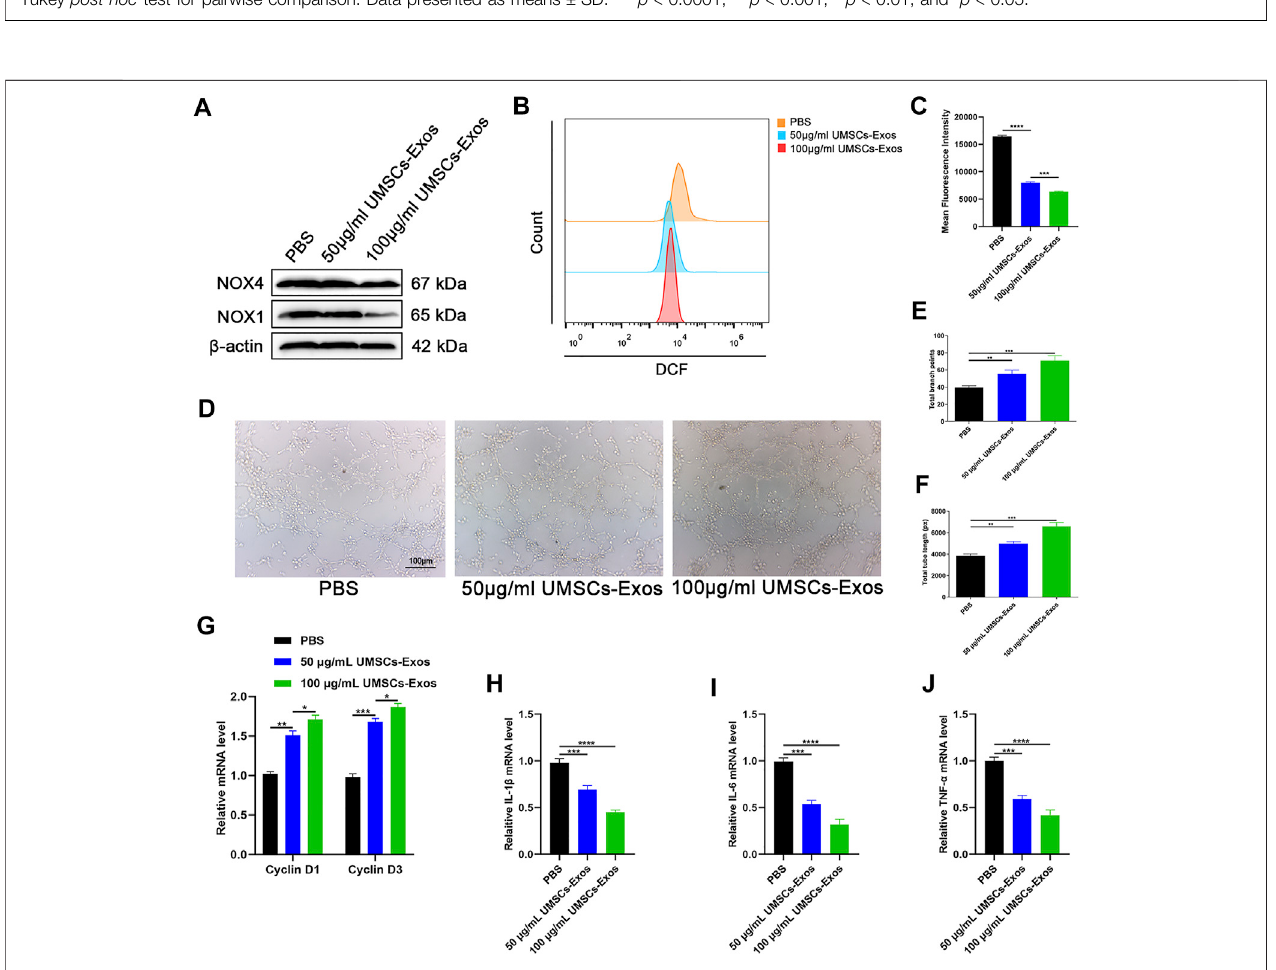
FIGURE 4 | HUC-Exos can improve oxidative stress injury caused by hyperglycemia in vitro . (A) Western blotting results of NOX1 and NOX4 in HUVECs following different treatments. (B) Reduction of ROS in HUVECs assessed by fl ow cytometry with the DCFH-DA probe following different treatments. (C) Quantitation of ROS depletion measured by the intensity of fl uorescence of HUVECs. (D) A tube formation assay was performed to visualize the cell capillary network formation of HUVECs. Scale bar: 100 μ m. (E, F) A tube formation assay was performed to visualize the cell capillary network formation of HUVECs. Scale bar: 100 μ m. (G) RT-qPCR resultsofcyclinD1andcyclinD3expressionsintheHUVECsfollowingdifferenttreatments. (H – J) RT-qPCRresultsofIL-1 β ,IL-6,andTNF- α expressionsintheHUVECs following different treatments. Differences were measured by one-way ANOVA followed by a Tukey post hoc test for pairwise comparison. Data presented as means ± SD. **** p < 0.0001, *** p < 0.001, ** p < 0.01, and * p < 0.05.